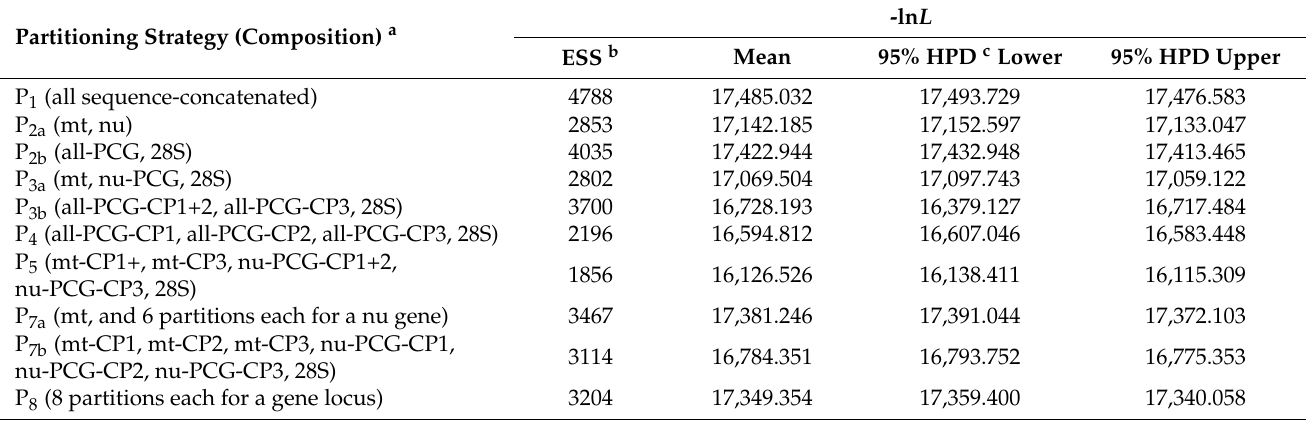
Table 3. Data-partitioning strategies and the mean-ln L and 95% credible interval of each strategy.